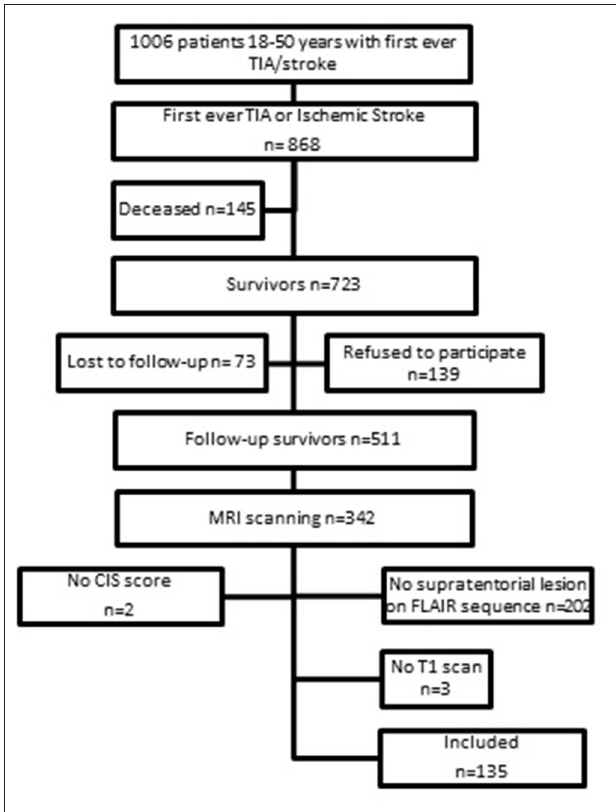
FIGURE 1 | Flowchart of study